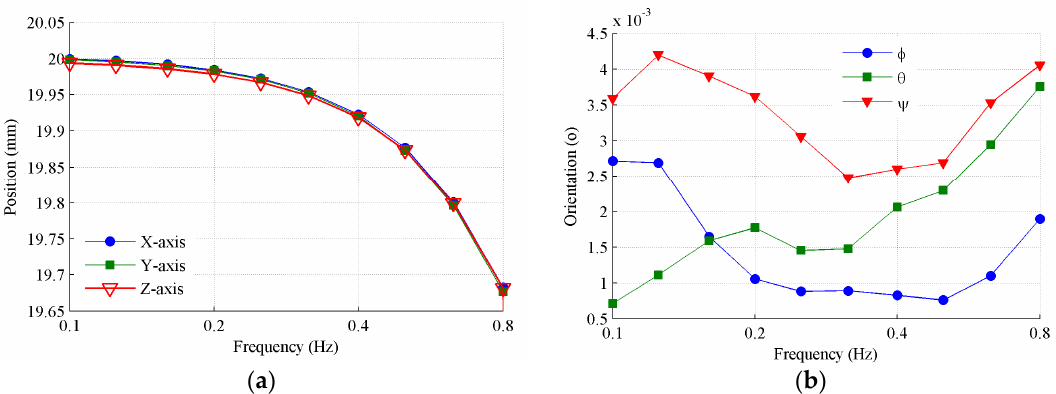
Figure 10. Positional orbit generated by the Stewart platform. ( a ) Amplitudes of position; ( b ) amplitudes of orientation in terms of Euler angles.